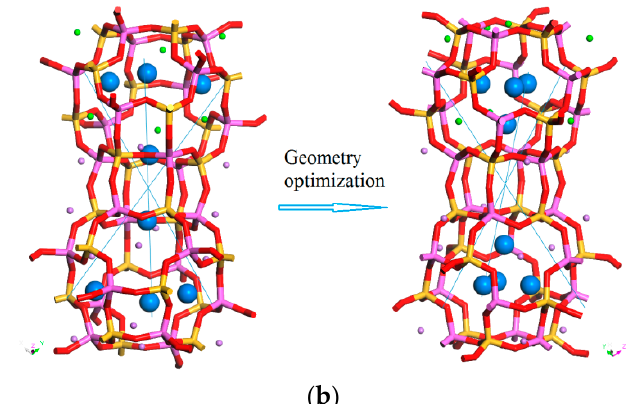
Figure 1. ( a ) The geometrically optimized structure of aAg 0.29 Li 0.71 -LSX in primitive ( left ) and traditional ( right ) unit cells with FD-3 space symmetry, with the three types of Li cation sites being identified by a, b, and c shown in the zeolite framework above primitive cell; ( b ) Notable transfer of Ag cation to the optimized location into sodalite cage by geometrical optimization for cAg 0.29 Li 0.71 -LSX. The blue, green, pink, yellow, and red balls represent Ag, Li, Al, Si, and O atoms respectively. The pink and yellow tetrahedrons symbolize Al–O and Si–O framework configurations respectively shown in right panel. Table 1. Atomic structures from first-principles calculations: lattice constant a, coordinating distances of metallic cations with zeolite framework d Li-O and d Ag-O , and atomic bonding length and angles in Al-Si-O cages, with the available experimental data of Li-LSX below for comparison [24]. Bonding Length/Å Bonding Angle/( ◦ ) Lattice d Li-O /Å d Ag-O /Å Materials Constant/Å